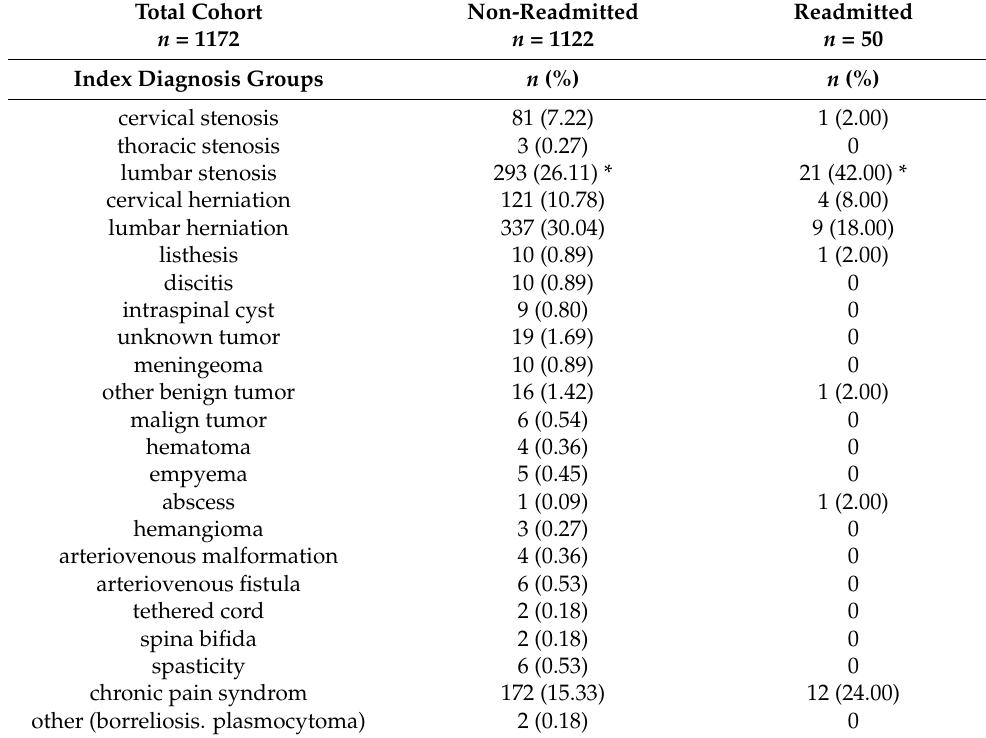
Table 3. Synopsis of index diagnosis groups comparing the readmitted and the non-readmitted population. Number, frequency, and p -value determined by Fisher exact